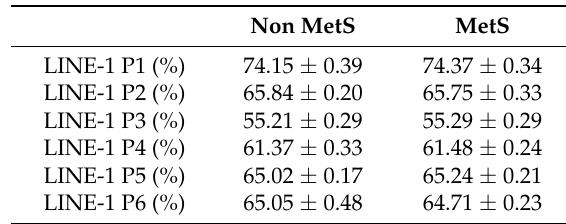
Table 2. DNA methylation level for each CpG position at LINE-1 pyrosequenced in both Non MetS and MetS groups. Values are given as the mean ±